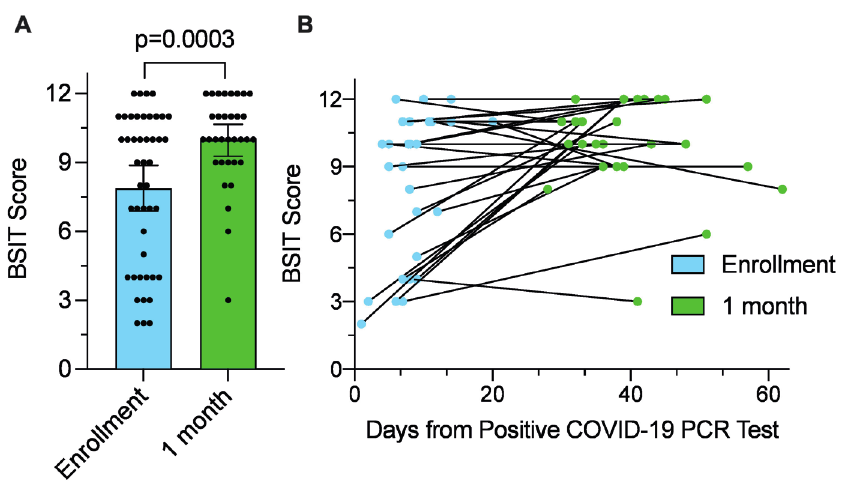
3. BSIT Score improved significantly in COVID-19 patients between 1 week and 1 month. A) BSIT Score improved by 2.0 (95% CI 1.0 – 3.0) from 7.9 (95% CI 7.1 – 8.6) to 9.9 (95% CI 9.0 – 10.7) in COVID-19 patients at baseline (blue) compared to 1 month later (green). B) Shows improvement in BSIT score (y-axis) from baseline (blue) to one month (green) with days from COVID-19 test on the x-axis. A score <9 indicates OD. The average